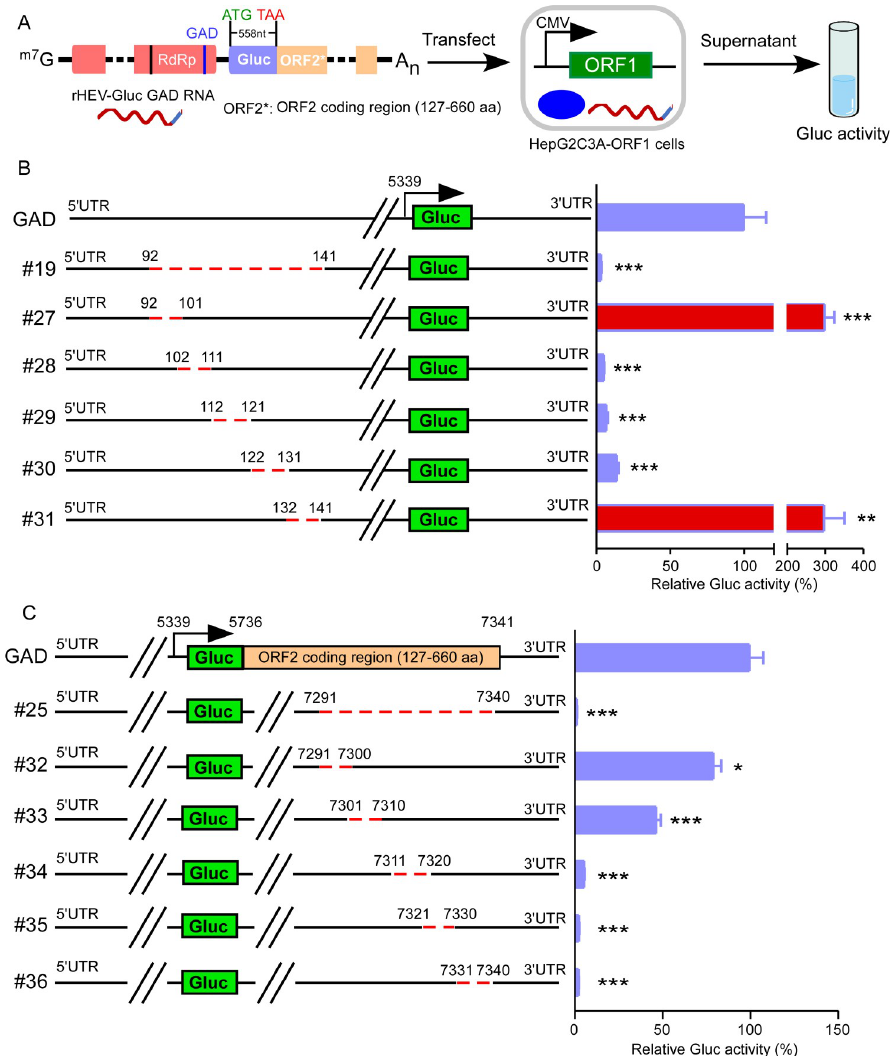
Fig 1. Identification of functional cis -acting RNA elements by ORF1 transcomplementation system. (A) Schematic representation of how cis -acting RNA elements were identified by utilizing an HEV replicon and ORF1 transcomplementation system. (B) and (C) Replication of HEV RNA mutants in ORF1-transcomplemented HepG2C3A cells. A series of truncated HEV RNA replicons harboring a secretory Gaussia luciferase (Gluc) reporter were transfected into HepG2C3A-ORF1 cells. Cell culture supernatants from each group were collected and Gluc activity measured two days post-transfection. The data are presented as the percentage of Gluc activity relative to that of the full-length rHEV-Gluc GAD. #27 and #31 mutants’ replication were enhanced, as indicated by increased Gluc activities (red). Values are means plus standard deviations (SD) (error bars) (n = 4). � , P < 0.05; �� , P < 0.01; ��� , P < 0.001. Significance assessed by one-way